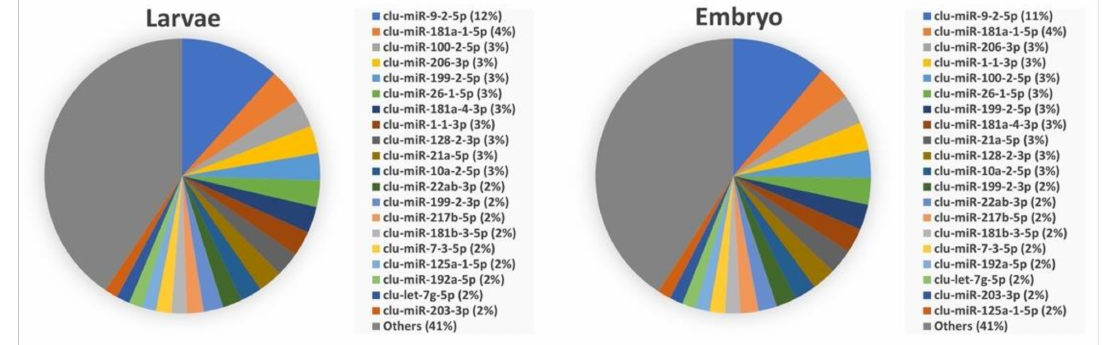
Figure 4. Twenty most abundant miRNAs in lumpfish embryos and